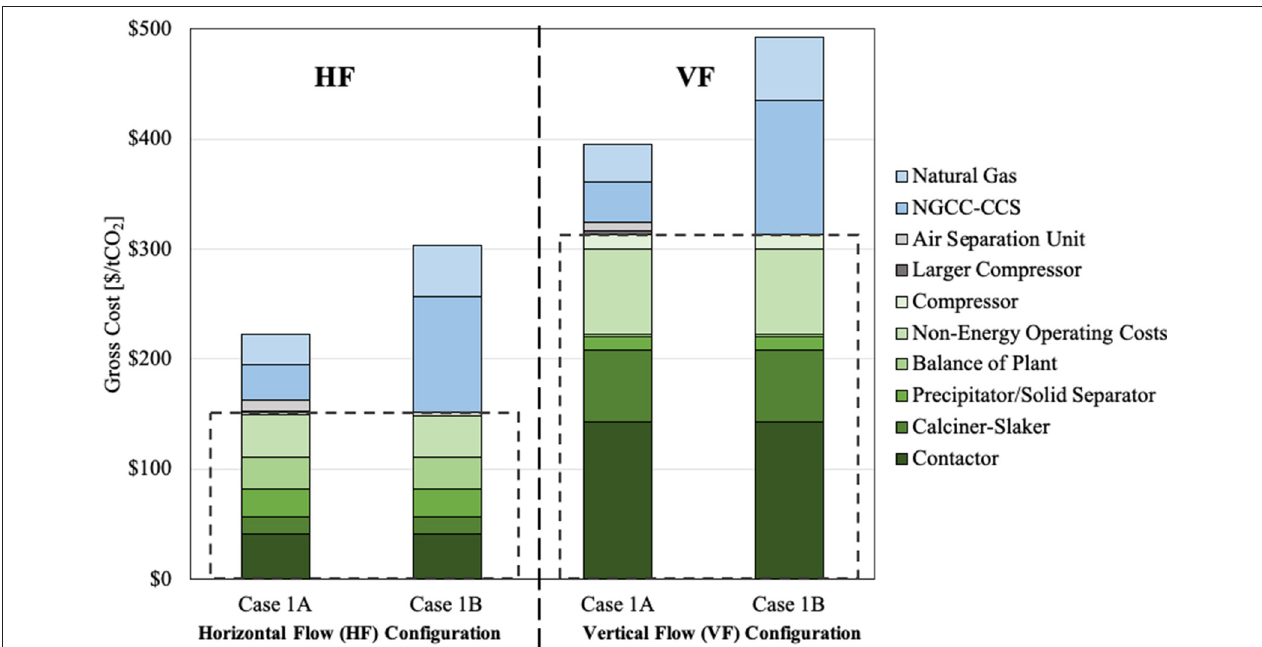
FIGURE 4 | Major cost components for Cases 1A and 1B. For both the VF and HF variants, the dashed lines isolate the costs that are common for Cases 1A and 1B, i.e., the costs other than those for the energy systems. These isolated costs are also the costs for the two variants that are carried forward for all the low carbon all-electric